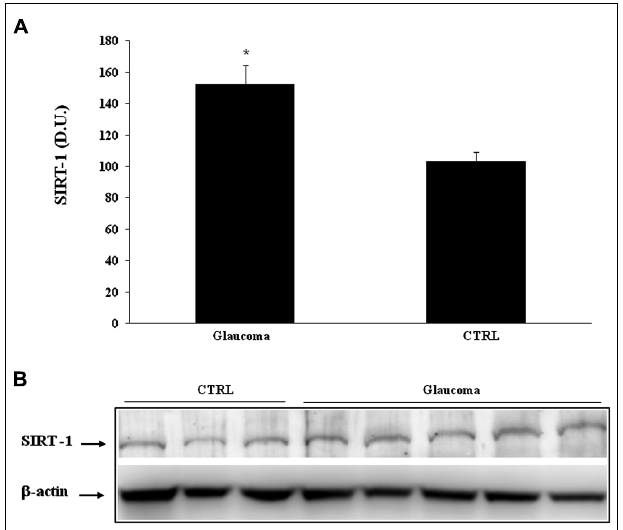
FIGURE 8 | (A) Thioredoxin protein levels in lymphocytes of glaucoma and control subjects. Samples from control and patients with glaucoma were assayed forTrx expression byWestern blot. A representative immunoblot is shown. β -actin has been used as loading control. (B) Densitometric evaluation: the bar graph shows the values are expressed as mean standard error of mean of 3 independent analyses. * P < 0.05 vs. control. D.U., densitometric units; CTRL, control.